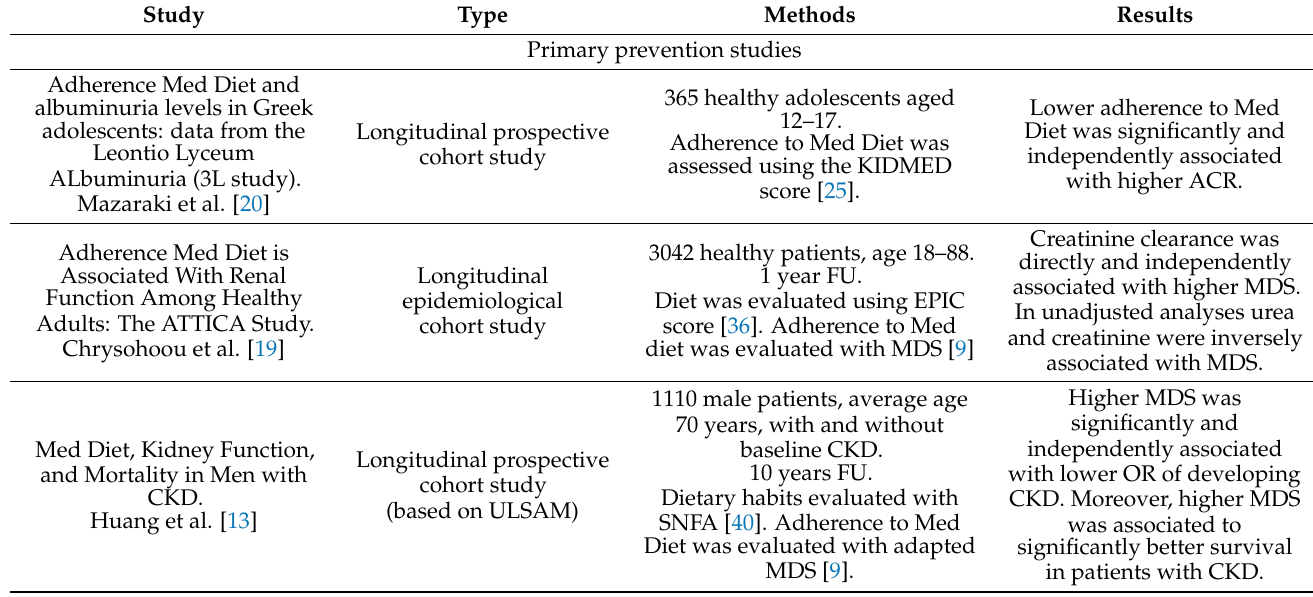
Table 1. Summary of principal studies and paper evaluating Med diet impact on kidney